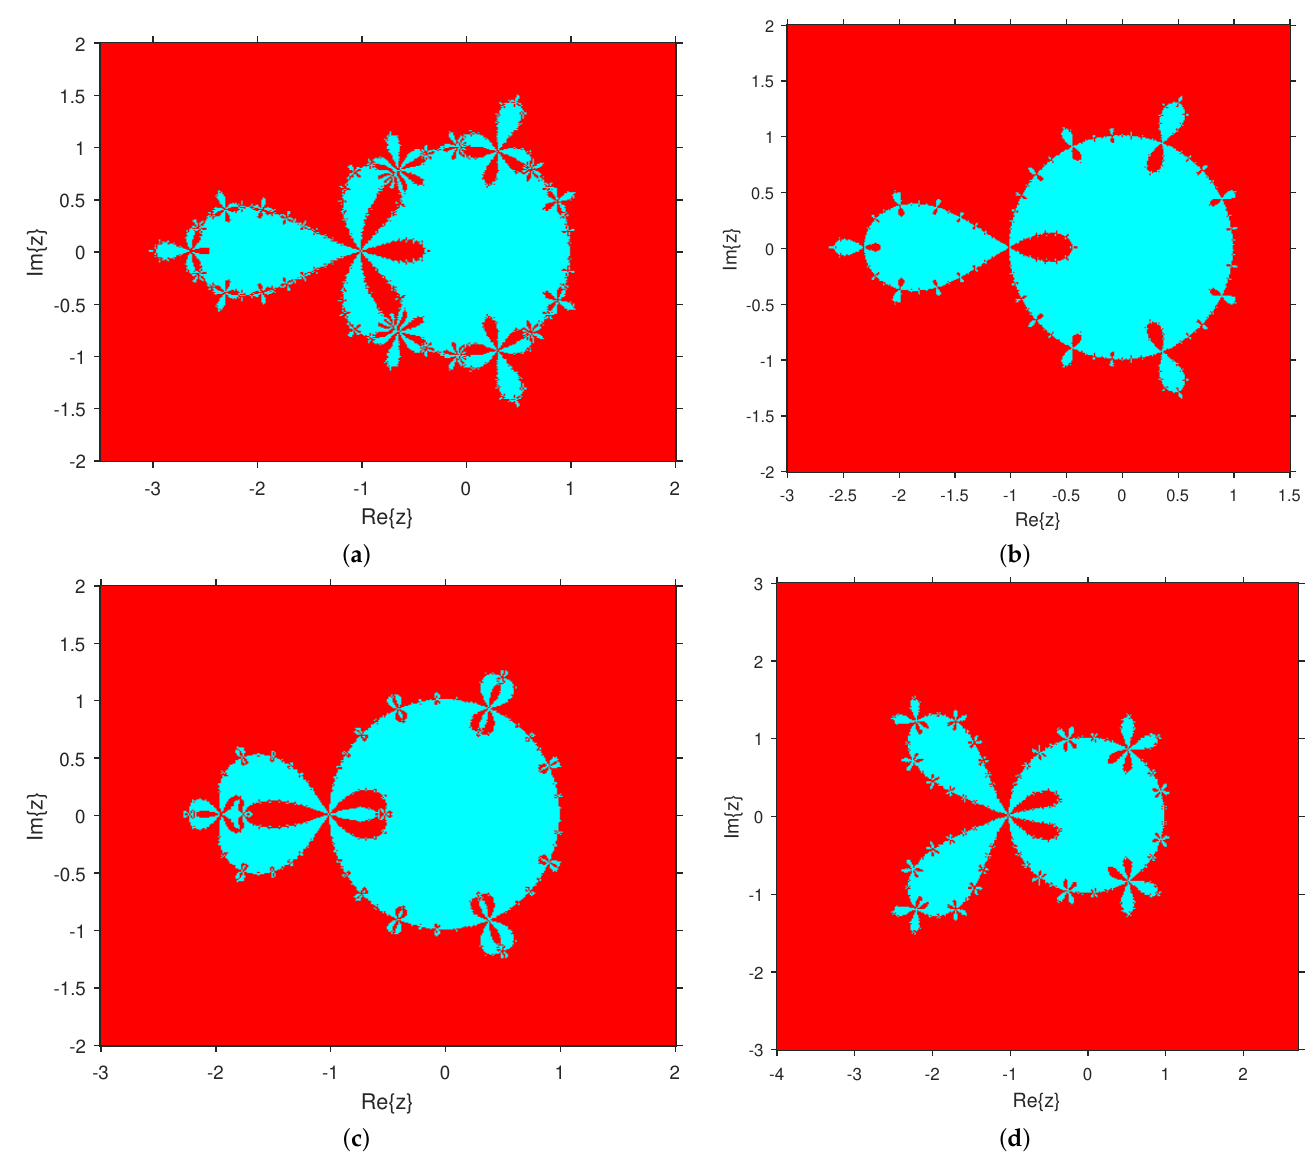
Figure 10. Dynamical planes. ( a ) θ = − 0.5, ( b ) θ = 0, ( c ) θ = 0.2, ( d ) θ =